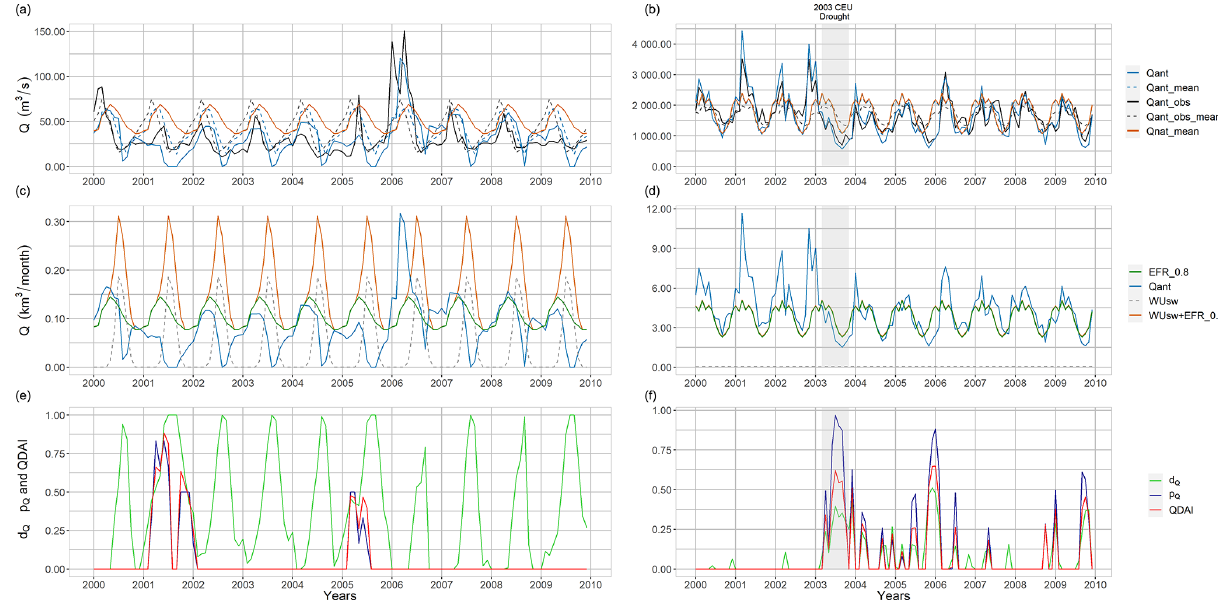
Figure 4. Streamflow drought hazard: example of a time series (2000–2010) of monthly surface water demand, surface water supply and mean seasonality of surface water supply, as well as d Q , p Q and QDAI (e, f) for a cell in the USA (a, c, e ) and Germany (b, d, f)